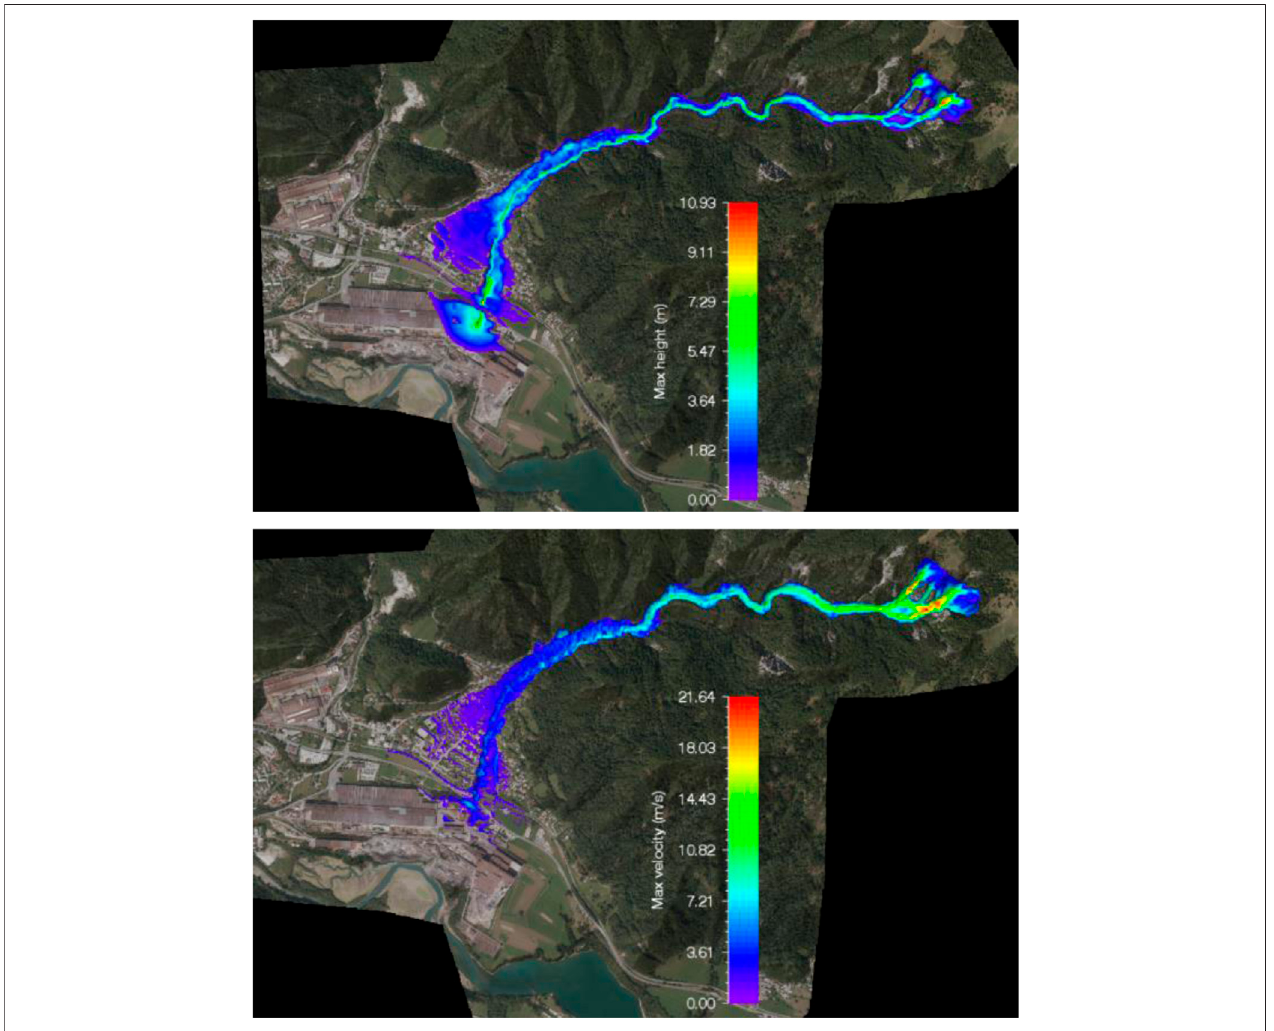
FIGURE 2 | AtypicalRAMMSmodellingresultsfortheUrbaslandslide(Koro ˇ skaBelaMunicipality,Slovenia)inacaseofpotentialdebris fl owtriggering.Maximumdebris fl ow height and velocity are shown. Results using μ (cid:1) 0.075 and ξ (cid:1) 200 m/s 2 and a hydrograph volume of 200,000 m 3 and a peak discharge of 2,680 m 3 /s are presented.